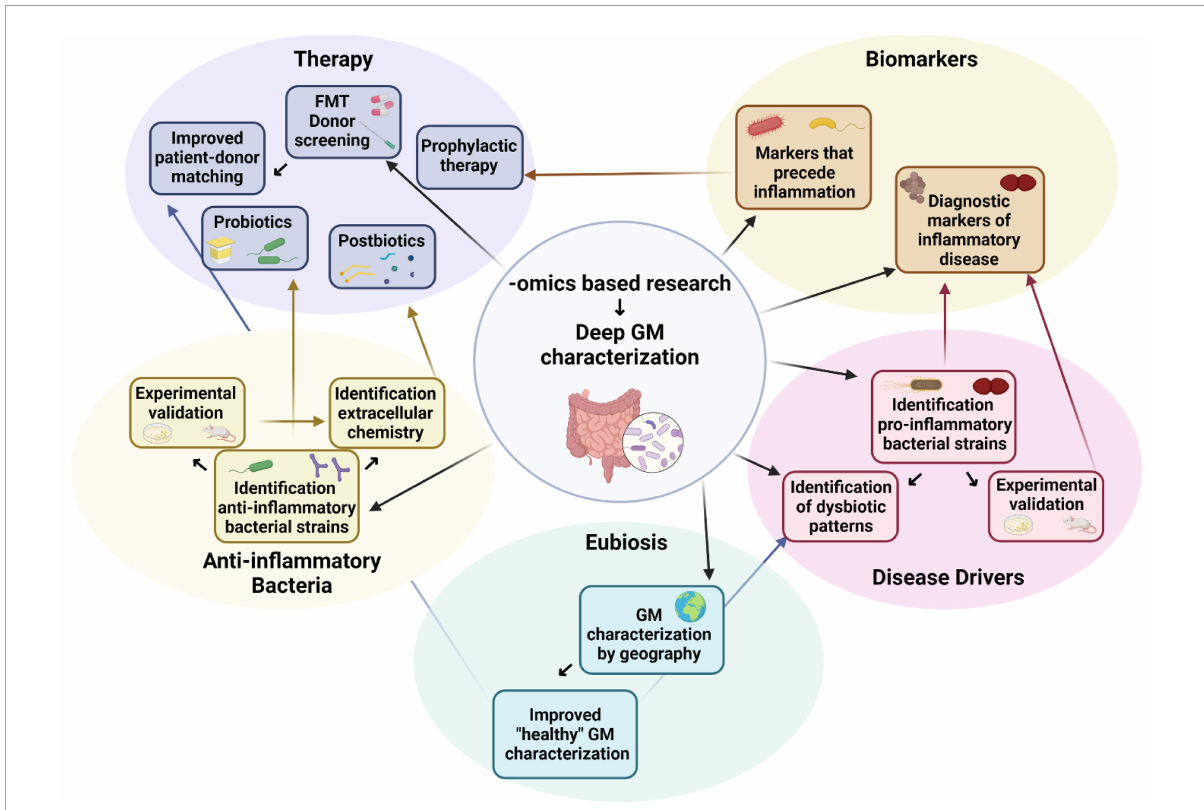
FIGURE1 How omics-based research can inform and improve study design and therapeutic strategies. Created with BioRender.com.